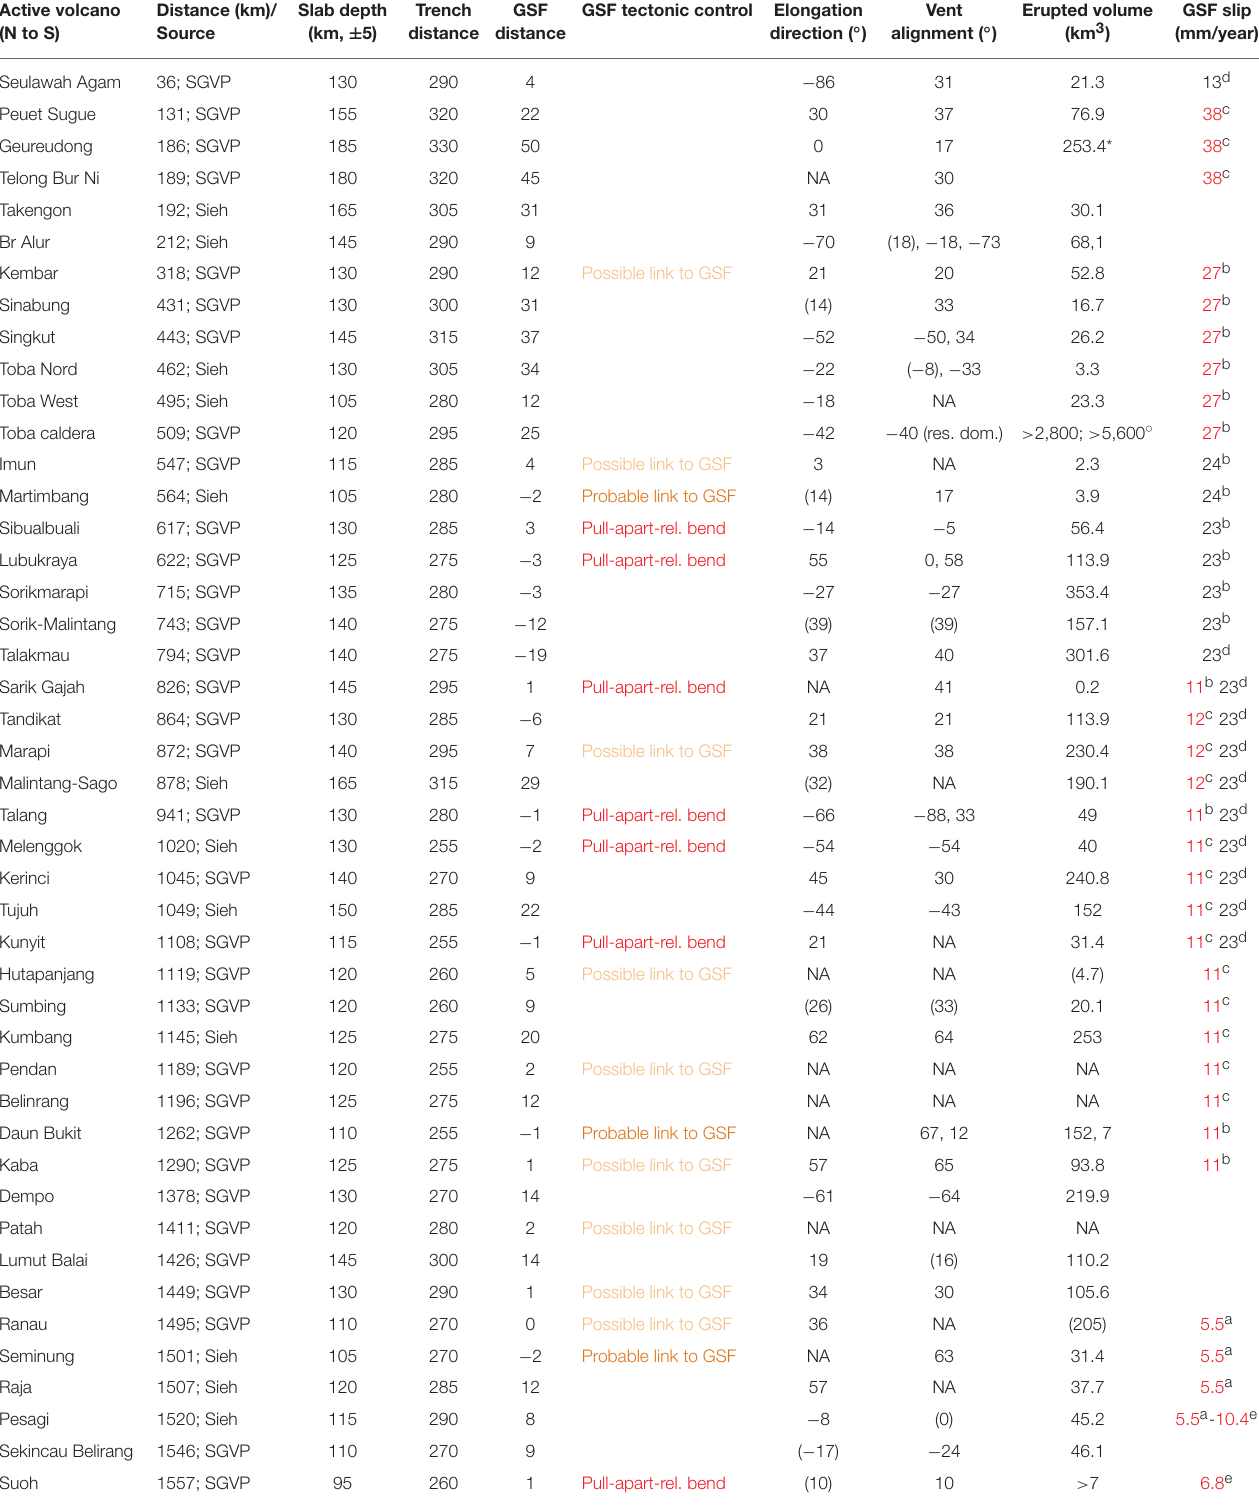
TABLE 1 | Summary of the main tectonic, structural and magmatic features of the active volcanoes on Sumatra. See text for details. Active volcano Distance (km)/ (N to S)